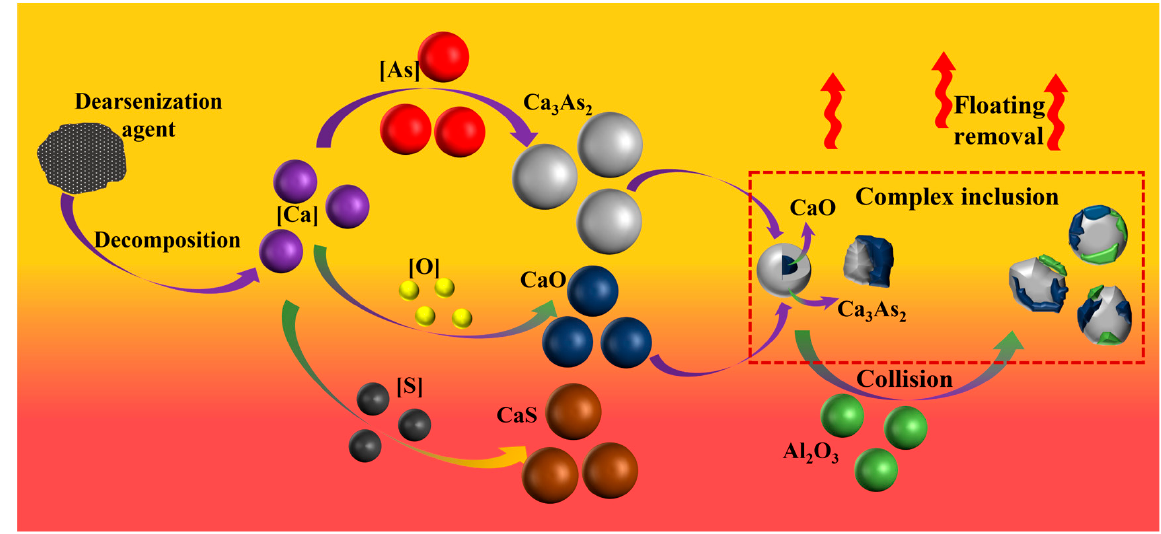
Figure 7. Mechanism of arsenic removal by adding arsenic removal agent into molten steel.